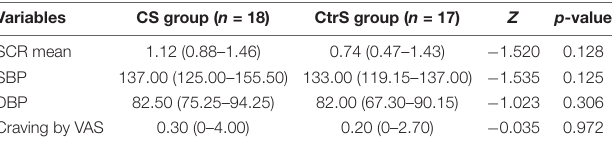
TABLE 3 | Baseline subjective and physiological indicators in the CS and CtrS groups.